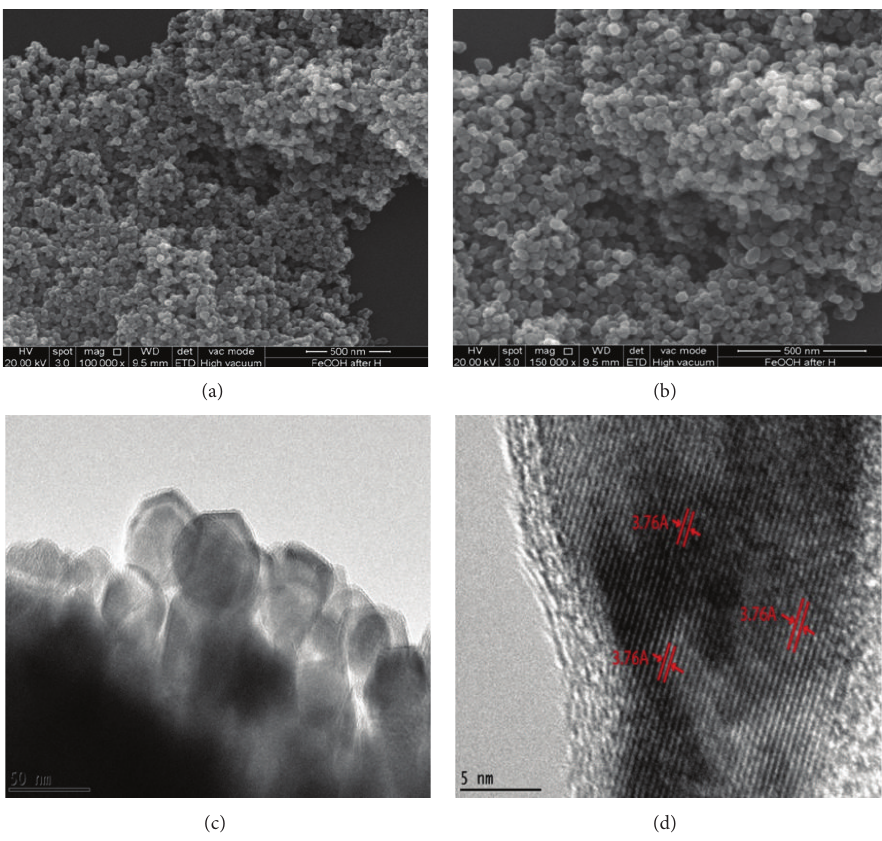
Figure 3: (a)-(b) FESEM and (c)-(d) HRTEM images of as-prepared 𝛼 -Fe 2 O 3